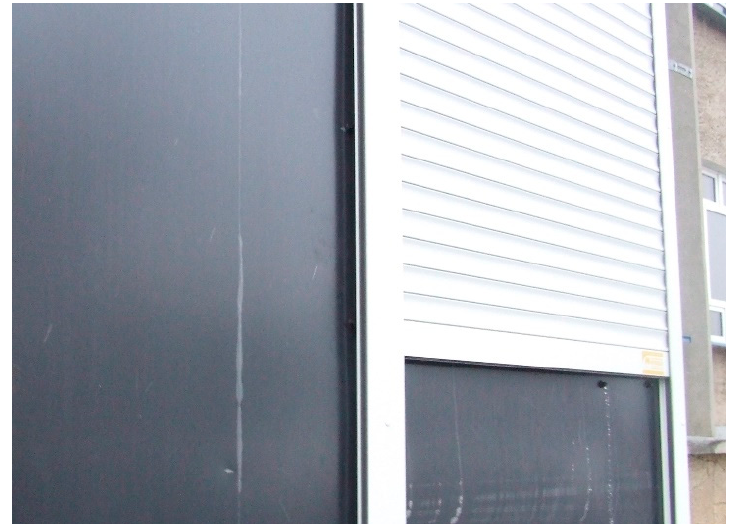
Figure 5. Thermal insulation shield located outside the absorber.